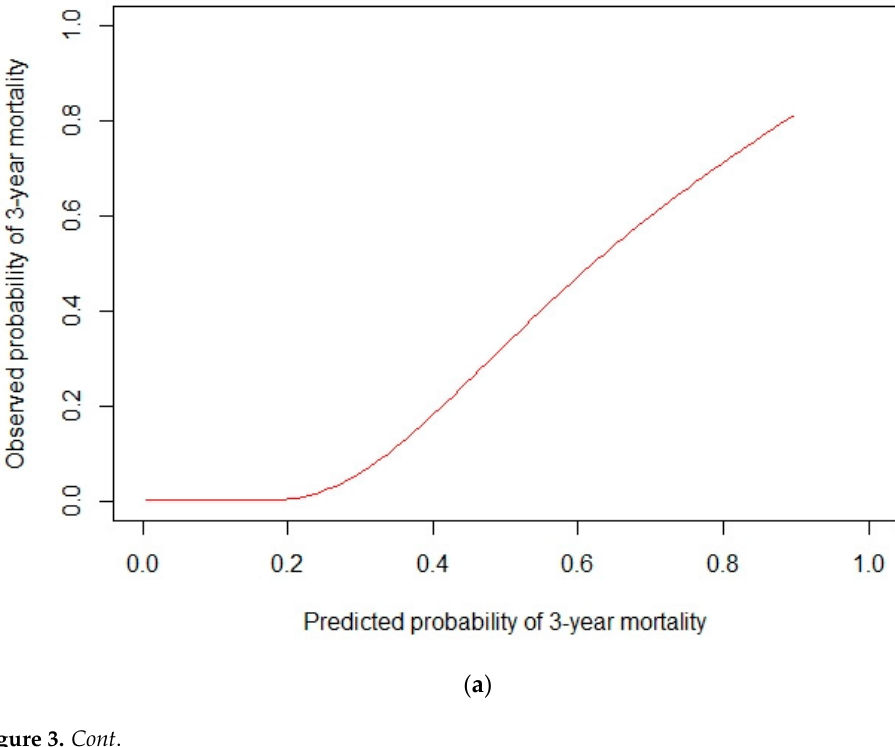
( b ) Figure 3. Calibration curves of the prognostic model. Plot demonstrates concordance between the predicted and observed survival in the validation cohorts at ( a ) 3 and ( b ) 5 years.